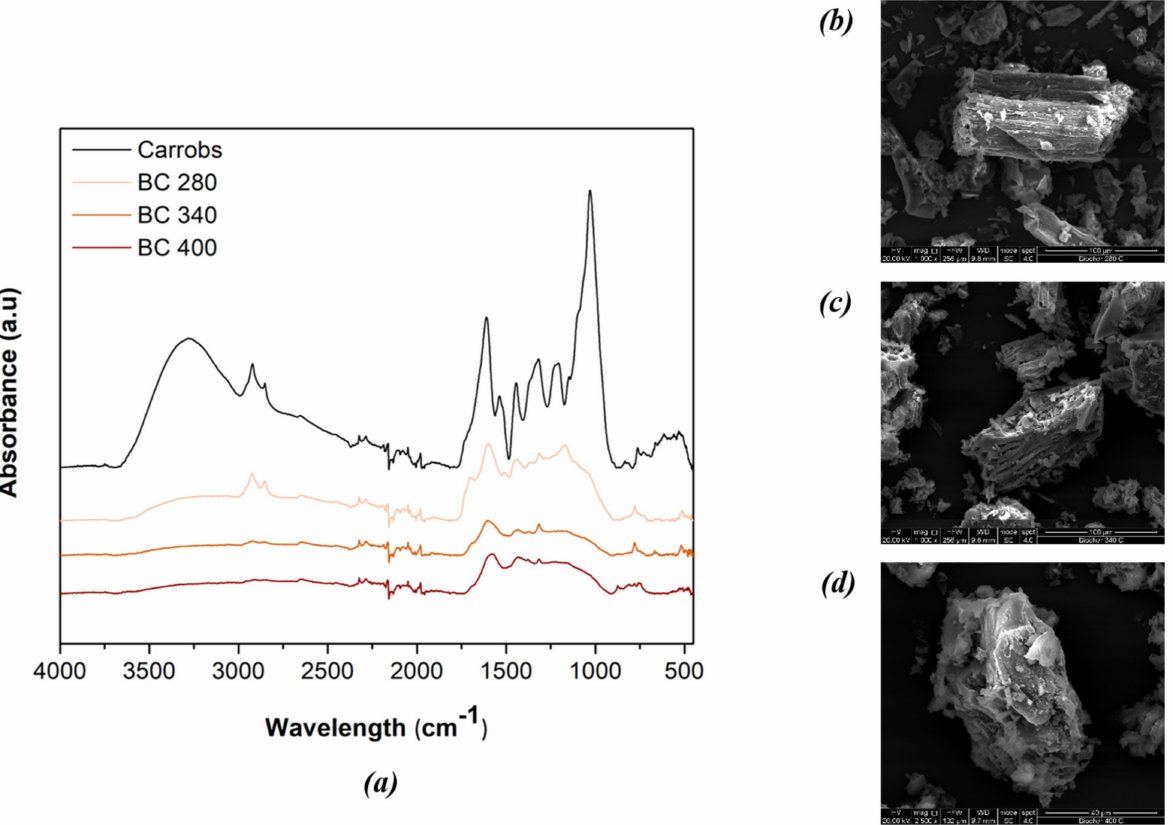
Figure 6. ( a ) ATR-FTIR spectra of carob before pyrolysis treatment and solid fractions at each pyrolysis temperature and SEM morphologies of ( b ) BC280, ( c ) BC340, and ( d )